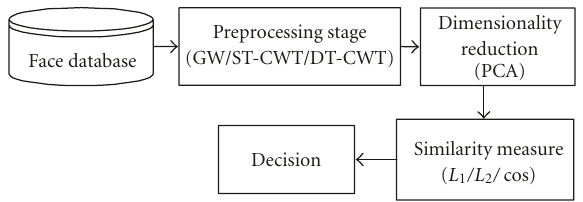
Figure 11: The block diagram of the proposed method.